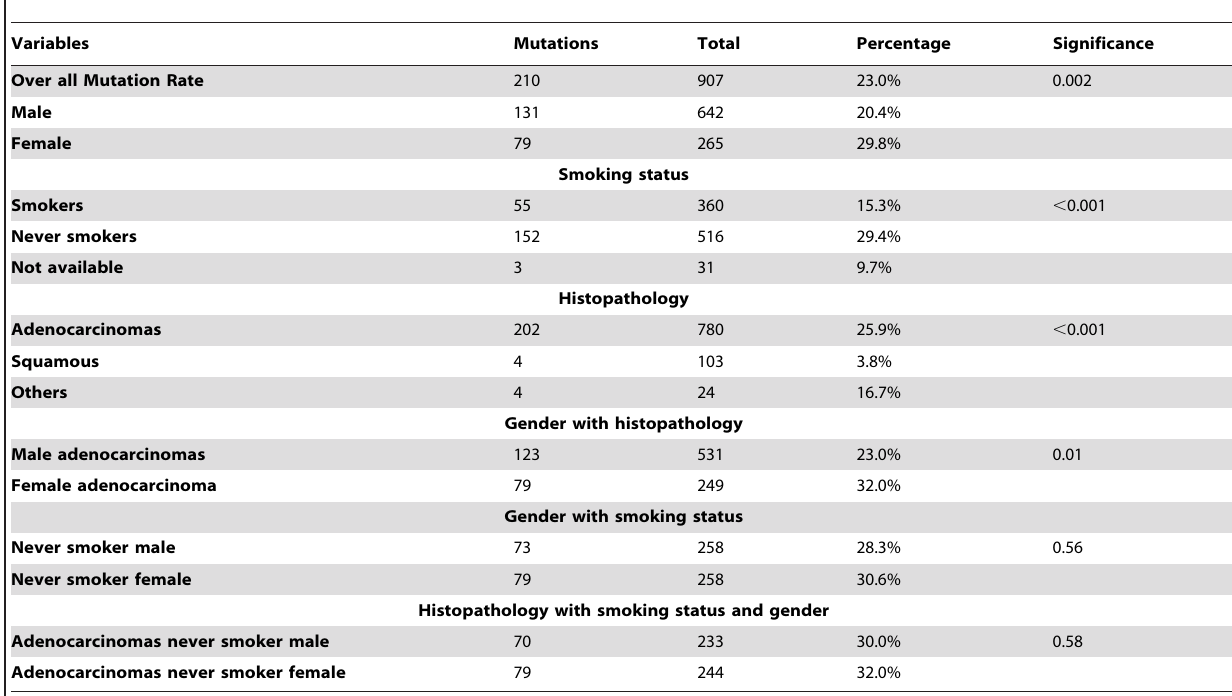
Table 3. Frequency and Overall mutation rate of different variables in NSCLC.